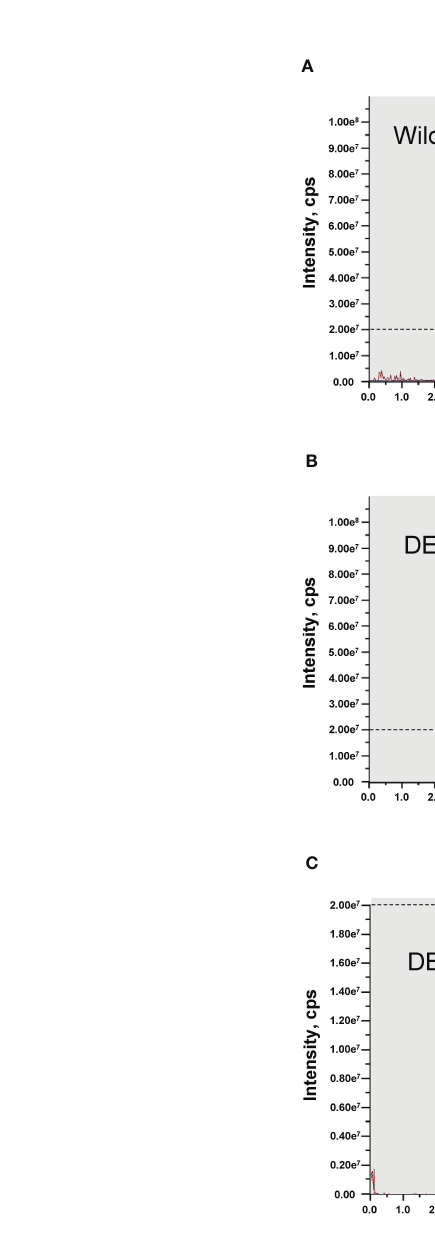
FIGURE 10 The HPLC-MS analysis of the culture extracts of the Curvularia clavata BAUA-2787 strains; (A) wild-type strain; (B) kk1C deletion strain (DELkk1C) as a representative of the KK-1 cluster gene deletion mutants except kk1A ; and (C) kk1A deletion stain (DELkk1A). The extracted ion chromatograms are shown for KK-1 ([M+H+] = 1113) and its putative mono-demethylated metabolites (a, b, c, d and e, [M+H+] = 1099). The dotted lines are drawn at the peak intensity of 2.00e7